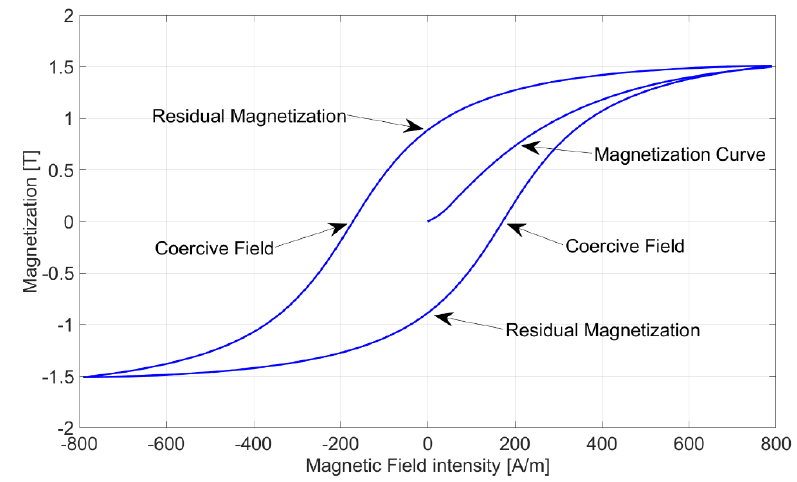
Figure 1. Typical hysteresis loop.